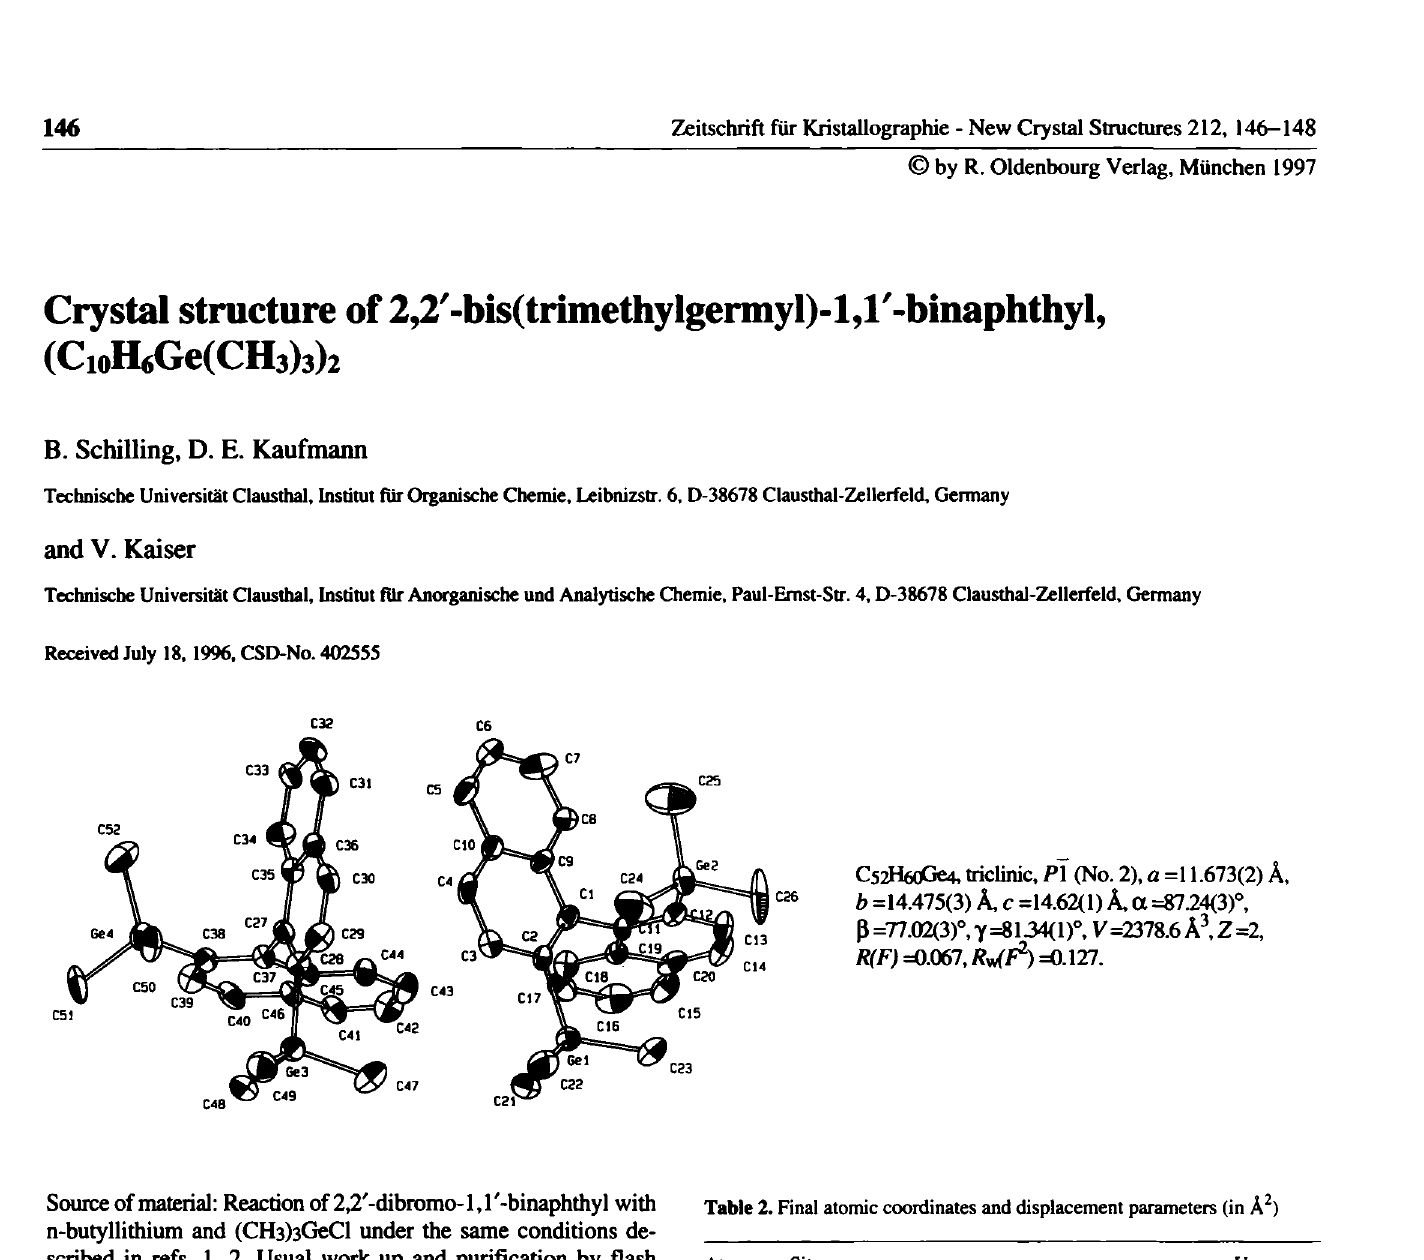
Table 1. Parameters used for the X-ray data collection Crystal: